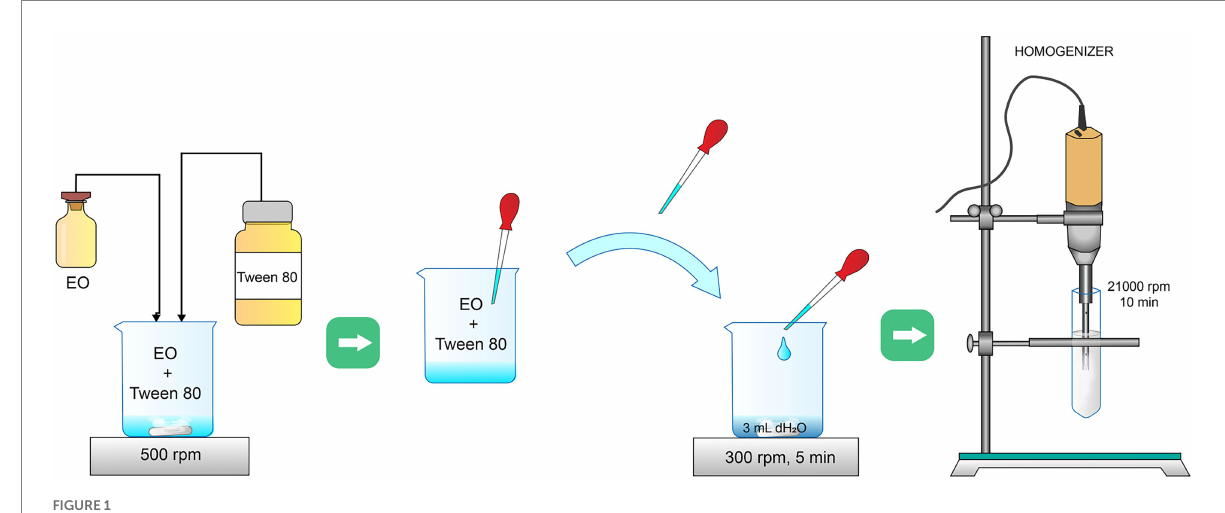
FIGURE 1 Methodology of cinnamon emulsion